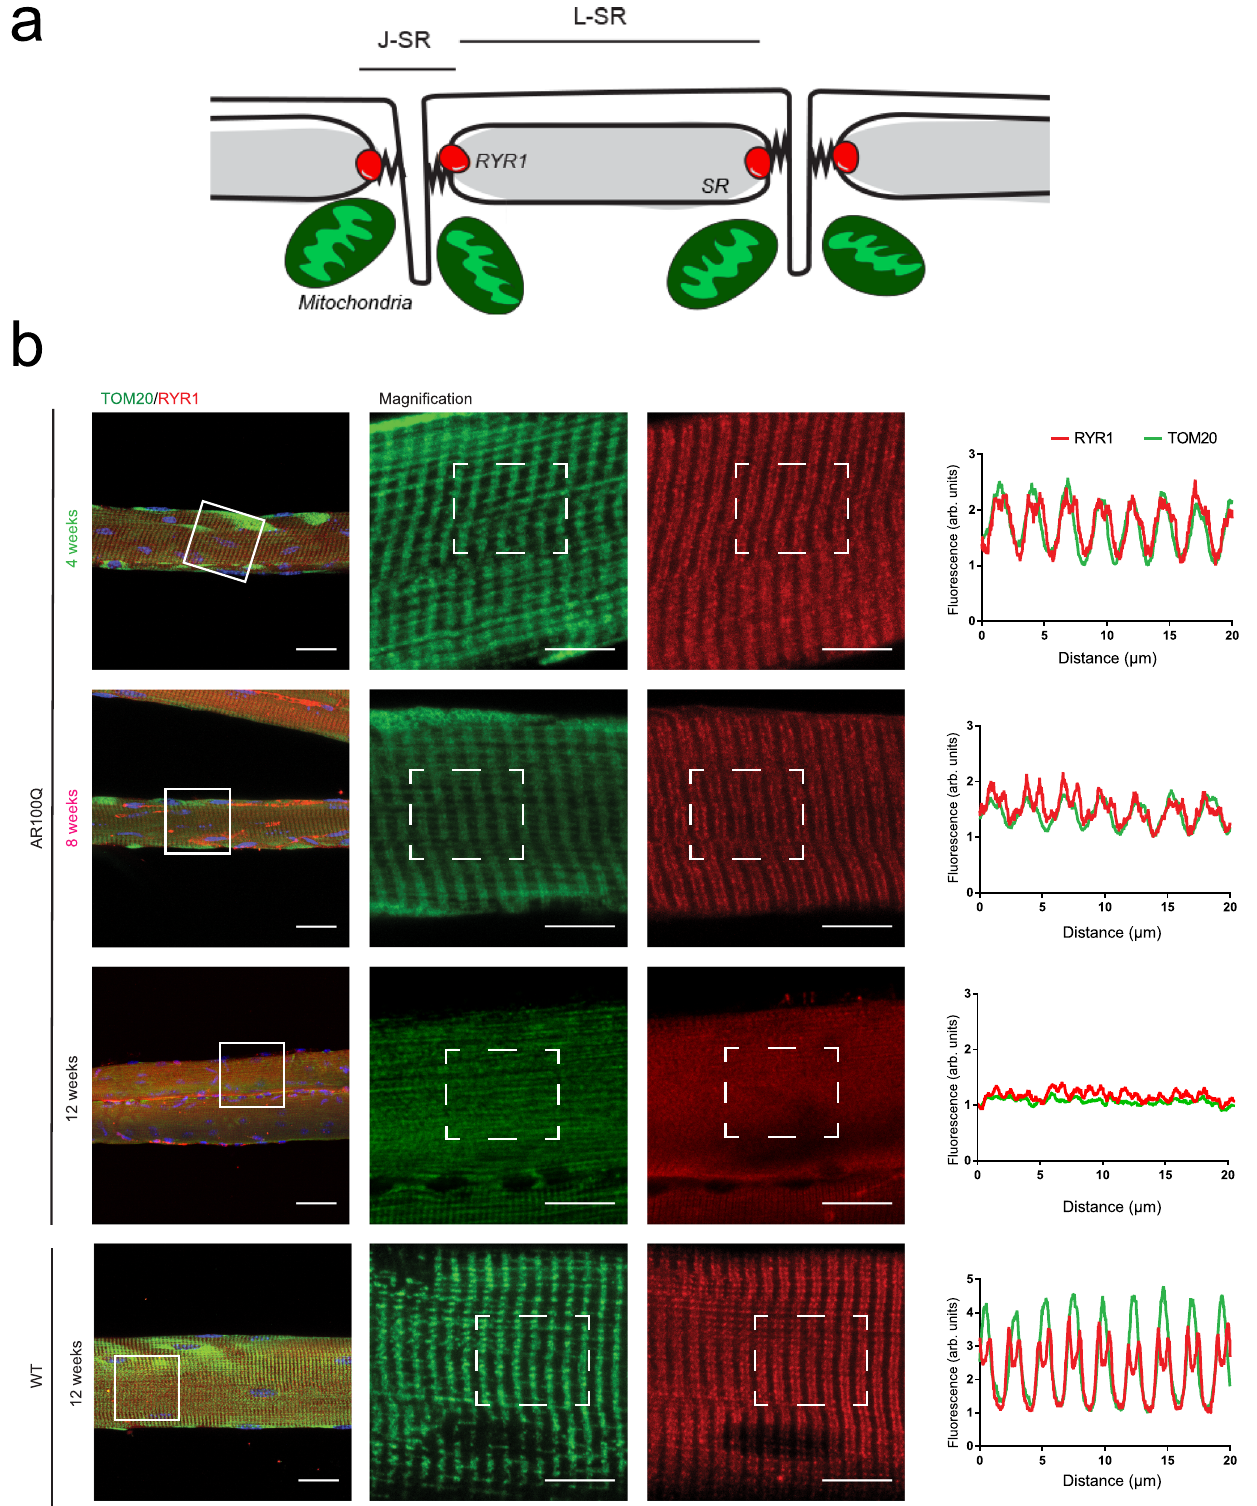
Fig. 6 | Disrupted mitochondrial organization at the Ca 2+ -release units in the skeletal muscle of SBMA mice. a Schematic representation of triads and mito- chondria in skeletal muscle fi bers. b Immuno fl uorescence analysis of RYR1 (red) and TOM20 (green) expression in fi bers isolated from the TA muscle of WT and